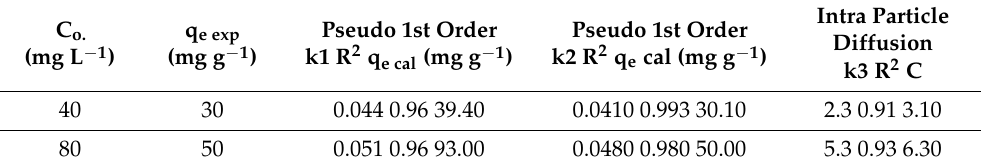
Table 3. Kinetic model parameters correlation co-efficient (R 2 ) for the CIPRO adsorption parameters on the mango Fe 3 O 4 /C adsorbent.